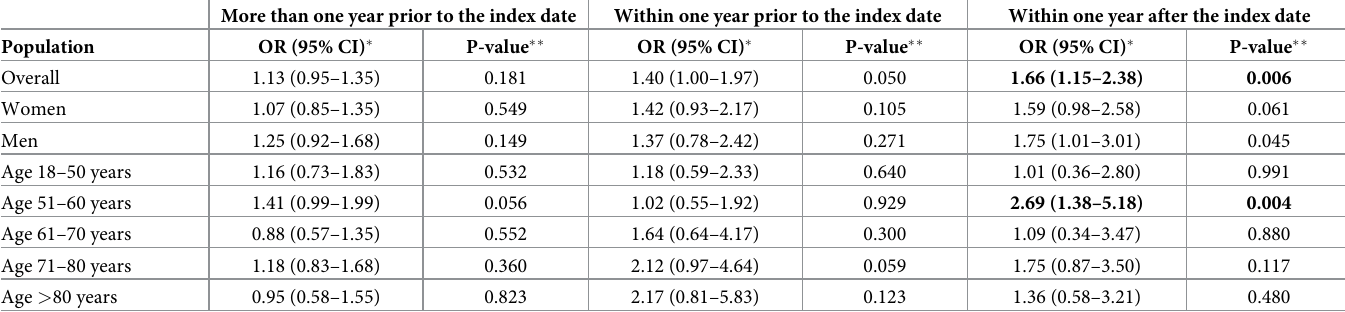
Table 2. Association between achalasia and depression in patients followed in general practices in the